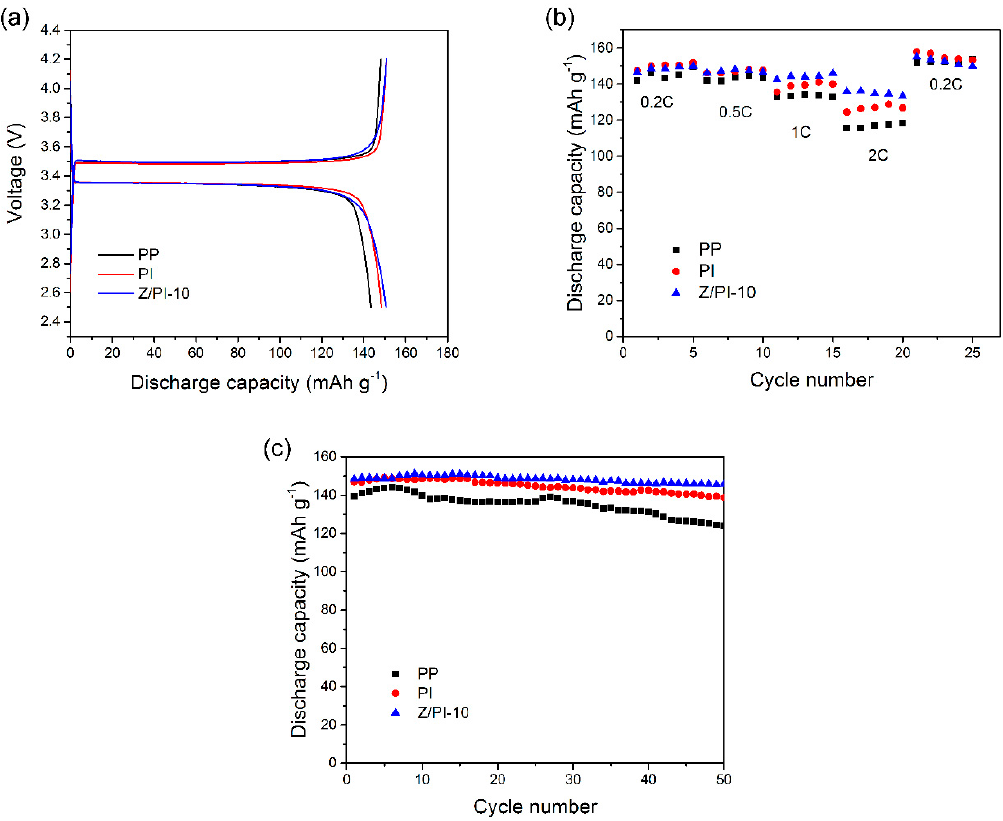
Figure8. TheelectrochemicalbehaviorsofLiFePO 4 / LicellsmadewithPPseparator, pristinePIseparator, Figure 8. The electrochemical behaviors of LiFePO 4 /Li cells made with PP separator, pristine PI and Z / PI-10 composite separator. ( a ) Initial charge / discharge (0.2 C / 0.2 C). ( b ) Rate performances separator, and Z/PI-10 composite separator. ( a ) Initial charge/discharge (0.2 C/0.2 C). ( b ) Rate (0.2 C / 0.2–2 C). ( c ) Cycle performances (0.5 C / 0.5 performances (0.2 C/0.2–2 C). ( c ) Cycle performances (0.5 C/0.5 C).